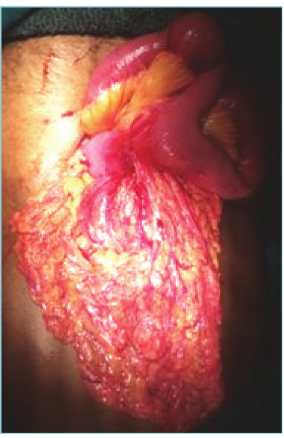
Figure 1: The intraoperative findings showing the jejunal loop and the adjacent mesentery and the segment of transverse colon.